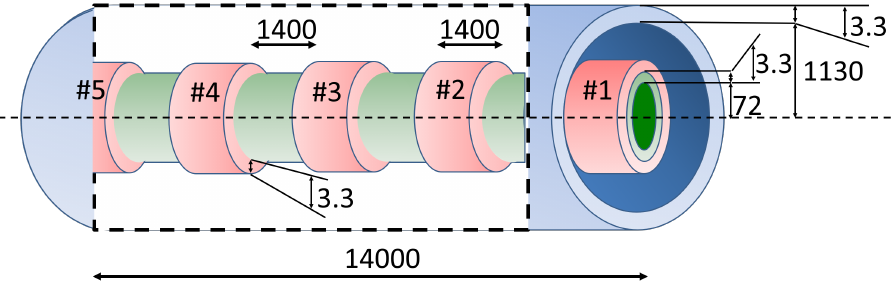
Figure 6. NBI PEEC model (not in scale). Blue: external shell; green: internal shell; red: magnetic core snubbers. Values in